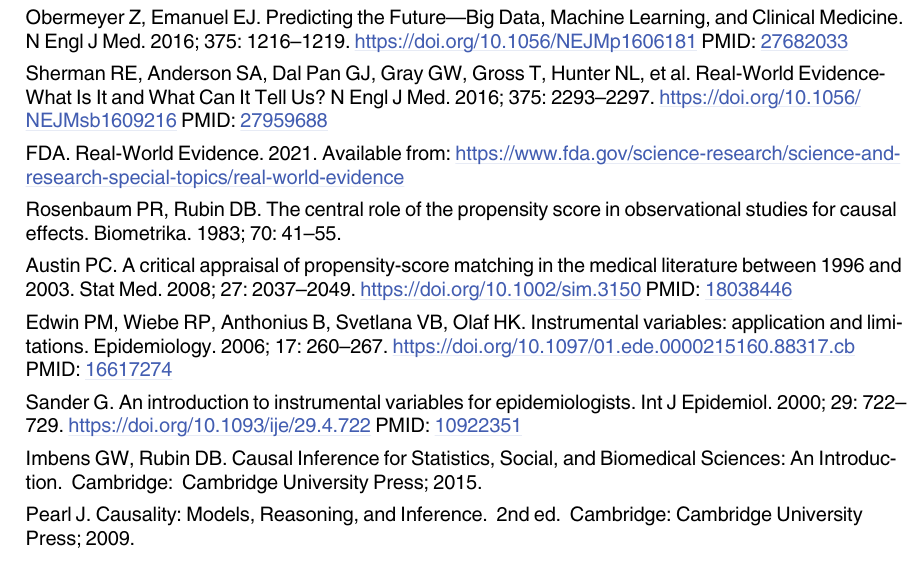
S1 Table. Comparison of g for the explanatory variable and the residual. g is the geo- CQ CQ metric difference for quantitatively evaluating the difference between quantum kernels and conventional kernels. The explanatory variable is the tail in the directed edge. The residual means that of a single regression analysis of the head in the directed edge on the tail in the directed edge. S2 Table. Comparison of the accuracy of qLiNGAM with the number of qubits of 5 and the number of depths of 2 and qLiNGAM with the number of qubits of 4 and the number of depths of 1 using the artificial data from the Erdos-Reny